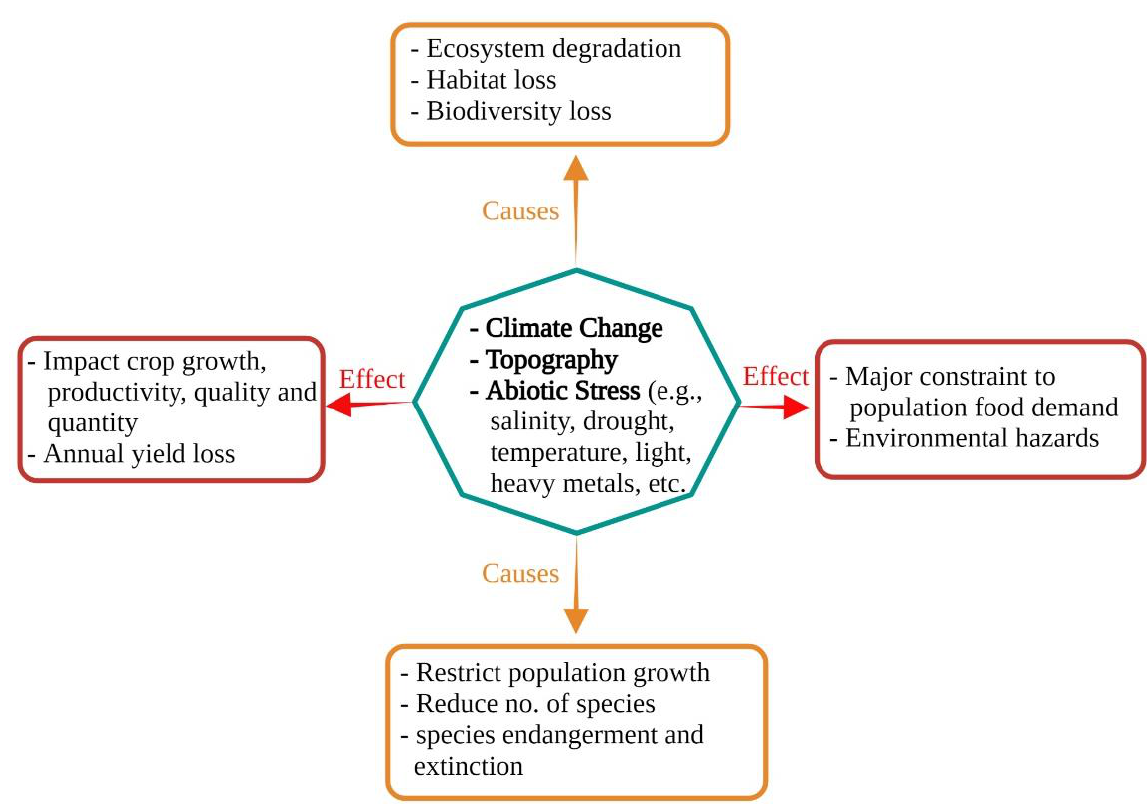
Figure 1. Schematic representation of effects and causes of abiotic stresses on different life forms, ecosystems, and crop yields.